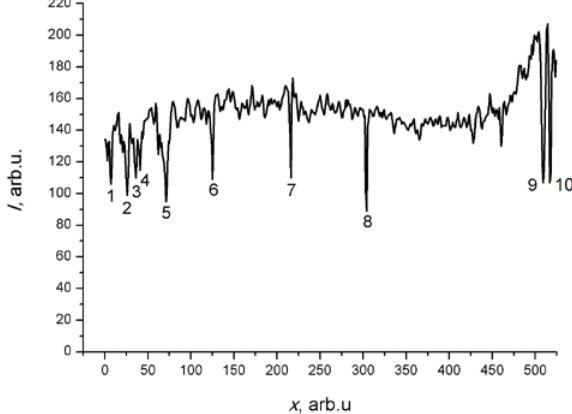
Fig. 2. Photometric data of the surface profile along the horizontal line shown in Fig. 1. 1 arb.u. (along the x axis) ≈ 400